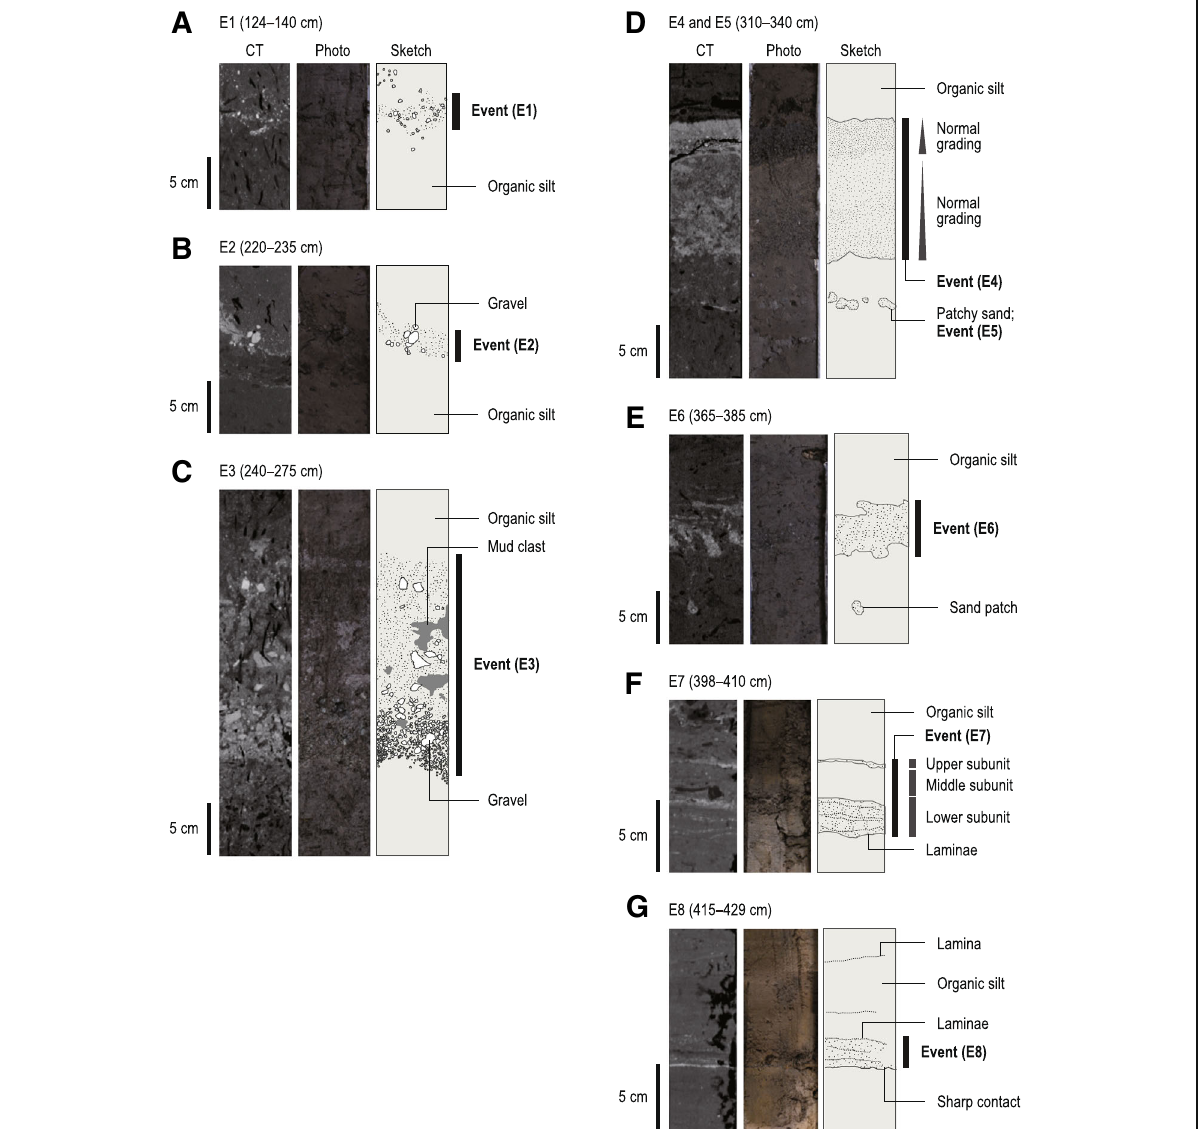
Fig. 4 Tomographic images (left), photographs (center), and interpretive sketches (right) of core MG05 showing sedimentary features of event deposits a E1, b E2, c E3, d E4 and E5, e E6, f E7, and g